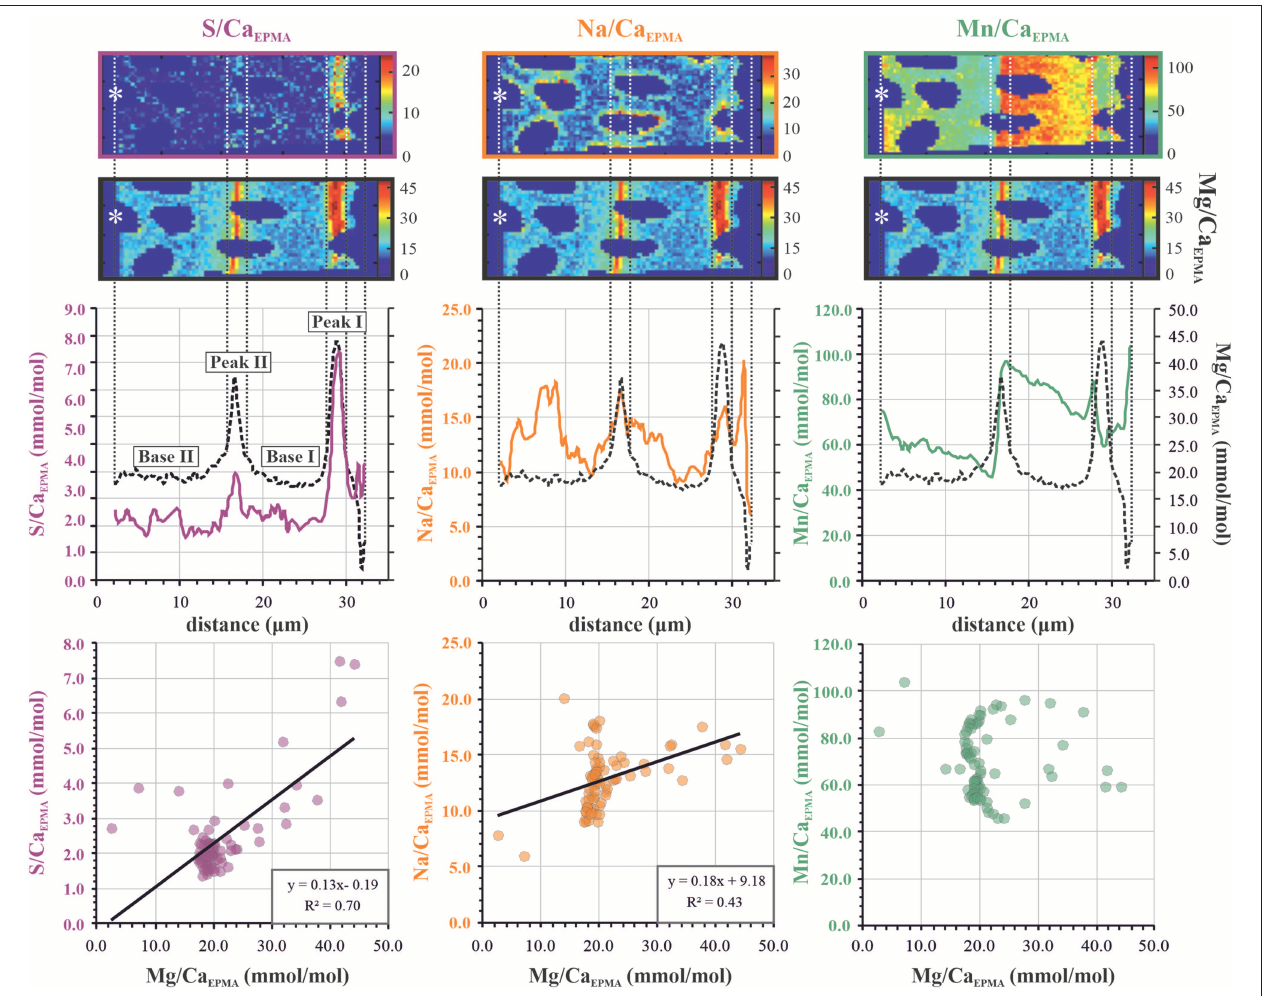
FIGURE 3 | Example of transect analysis for S/Ca EPMA (left panels; purple), Na/Ca EPMA (center panels; orange), and Mn/Ca EPMA (right panels; green). The top three panels show E/Ca EPMA transect maps with an asterisk indicating exterior of the foraminiferal test (for full EPMA area, see Figure 2 ). Middle panels show distribution profiles calculated from the average E/Ca EPMA per column over the transect map. In the S/Ca EPMA profile, primary (peak I and base I) and secondary (peak II and base II) bands are indicated. The lower panels show E/Ca EPMA vs. Mg/Ca EPMA values of the distribution profile. The dotted vertical lines are added to illustrate the location of Mg/Ca bands. EPMA, electron probe